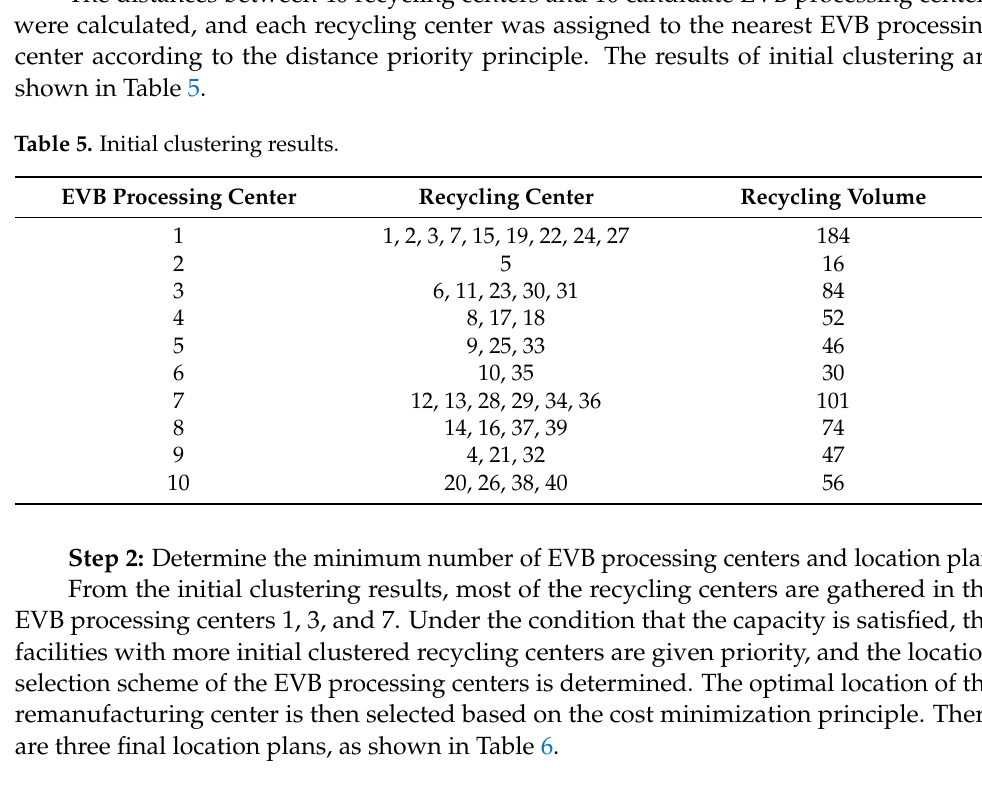
Table 6. Possible location schemes.